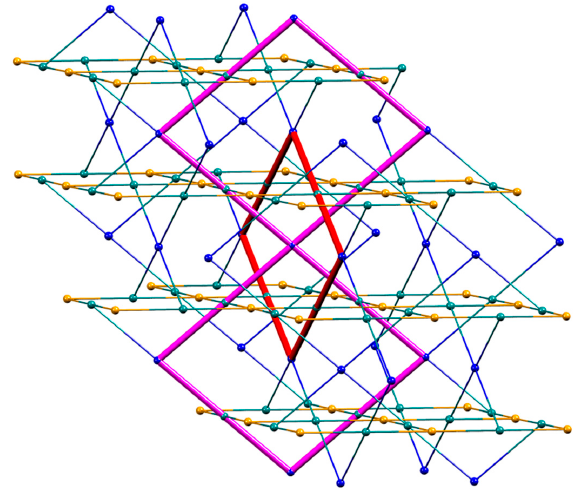
Figure 5. Part of the 3D net in [{Co( 1 )(NCS) 2 } · MeOH · 3CHCl 3 ] n viewed down the crystallographic ( a ) a -axis and ( b ) c -axis. Colour code for the nodes: Co1 blue, Co2 orange, ligand centroids green.